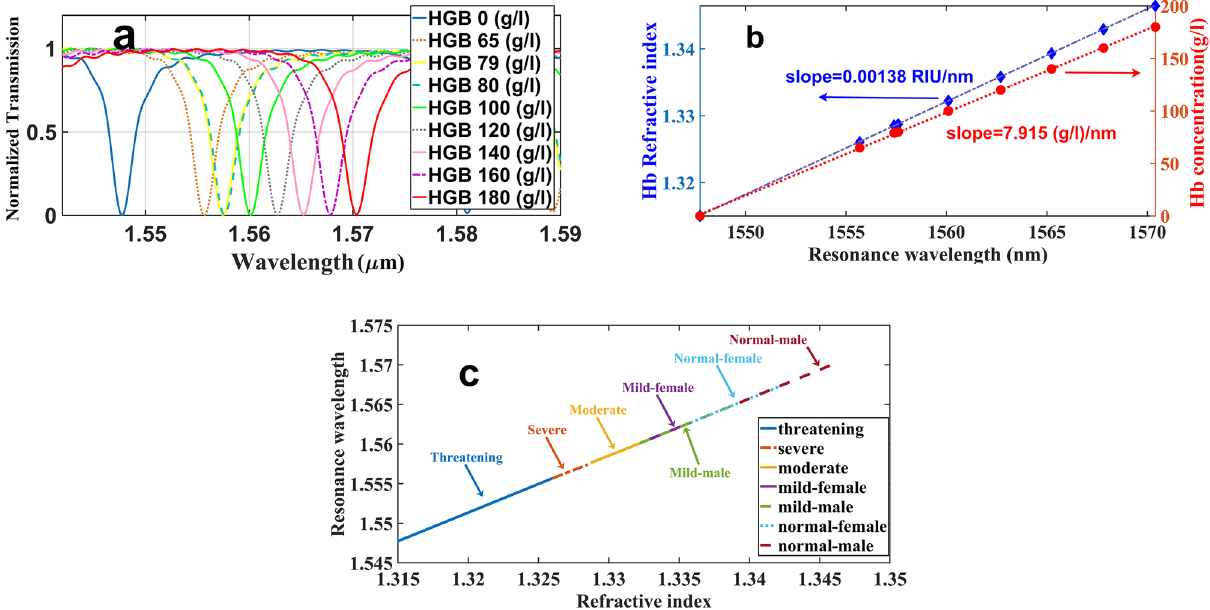
Figure 10. ( a ) The resonance wavelength shift in terms of variations of analyte hemoglobin concentration ( b ) the hemoglobin (Hb) refractive index (blue) and Hb concentration (red) sensing lines against the wavelength of the resonance peaks ( c ) the sensing line for the diagnosis of anemia patients’